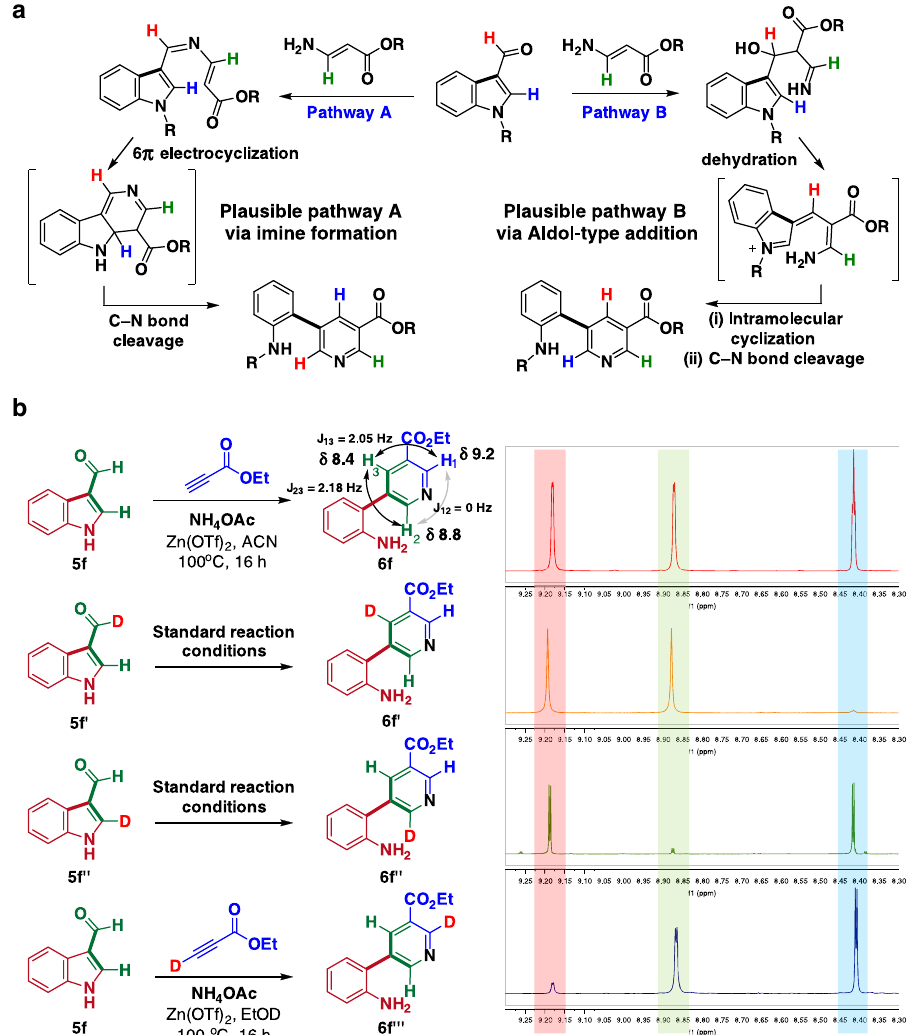
Fig. 5 Plausible mechanisms of nature-inspired transformation of (aza)indole scaffolds into substituted meta -aminoaryl nicotinate scaffolds. a Plausible mechanism A via imine formation and 6 π electrocyclization followed by C – N bond cleavage and re-aromatization. Plausible mechanism B via Aldol-type addition, dehydration, and intramolecular cyclization followed by C – N bond cleavage and re-aromatization. Each proton in meta- aminoaryl nicotinates was color-coded to track its sources in starting materials. b Deuterium-labeling experiments revealed that our structural remodeling of (aza) indoles into substituted meta -aminoaryl nicotinate scaffolds occurs via plausible pathway B, as con fi rmed by NMR